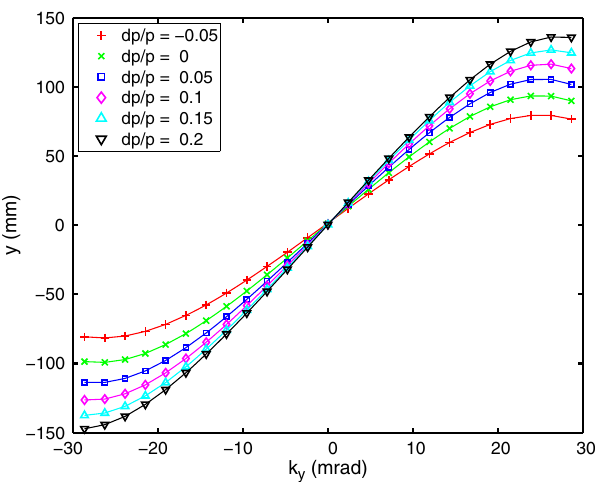
FIG. 17. Out-of-plane offset of the beam center at the isocenter as a function of out-of – plane sweeper scan angle at different momentum